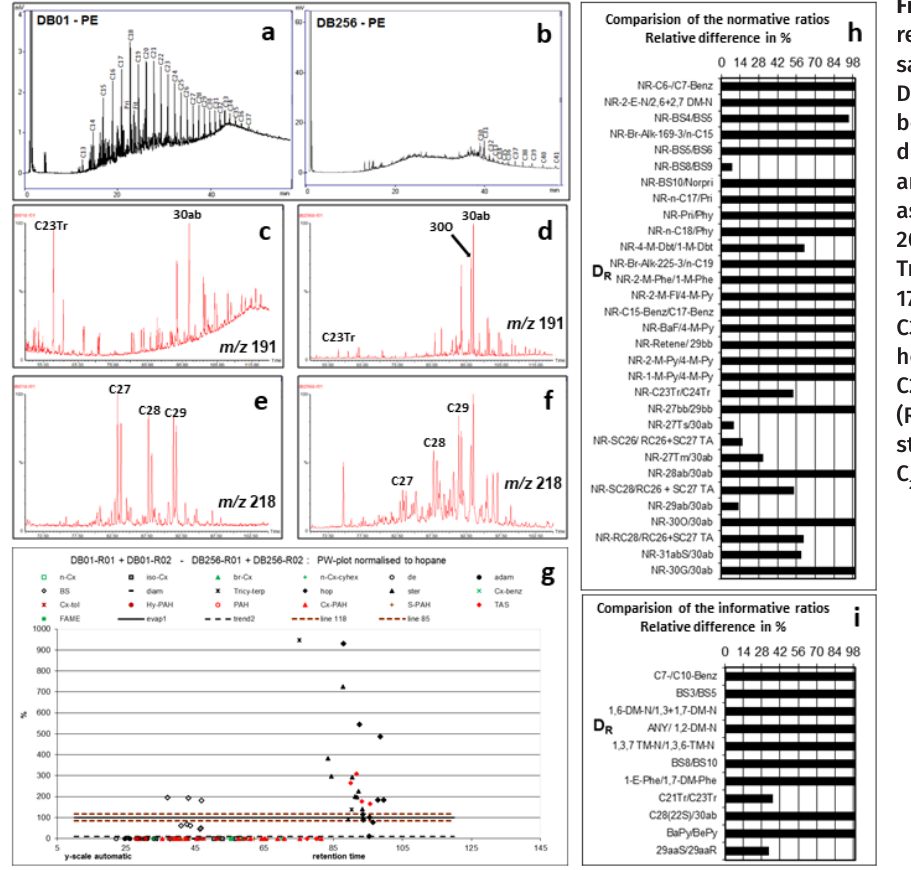
Figure 12. Combined results between samples DB01 and DB256, indicating that both samples are from different sources